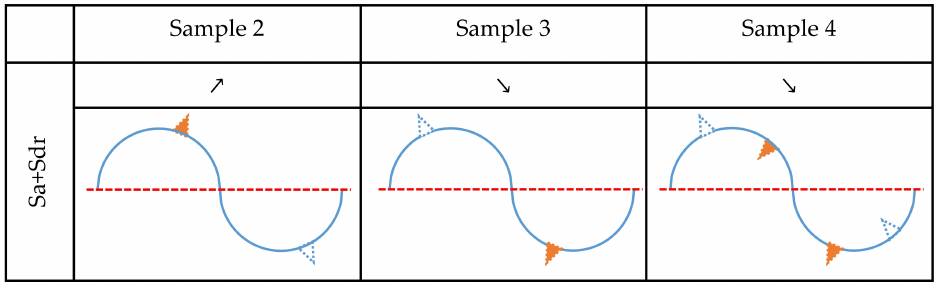
10Figure 10. Determination of dominant corrosion effects that correlate with changes of parameter Sa Figure and Sdr. The empty blue triangle represents material loss while the orange filled triangle represents material gain. Results of paired t test are symbolically represented by symbols ≈ , (cid:37) , (cid:38) . These symbols represent insignificant difference, significant increase, and significant decrease in specific parameters,